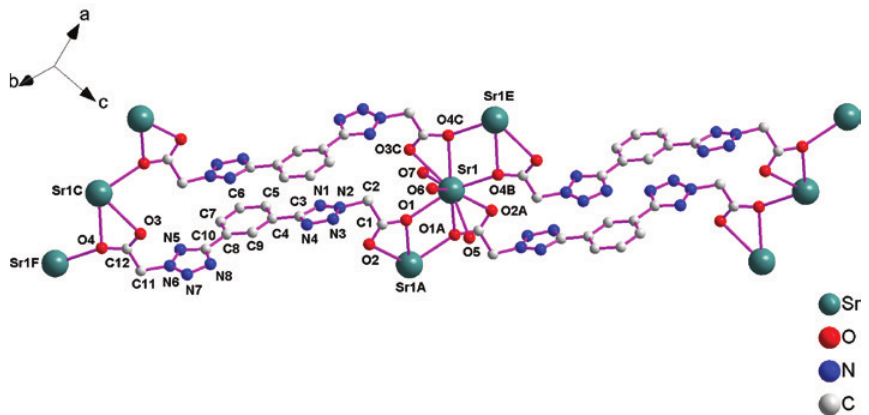
Figure 4: The coordination environment of Sr(II) in 2 . Hydrogen atoms are omitted for clarity.